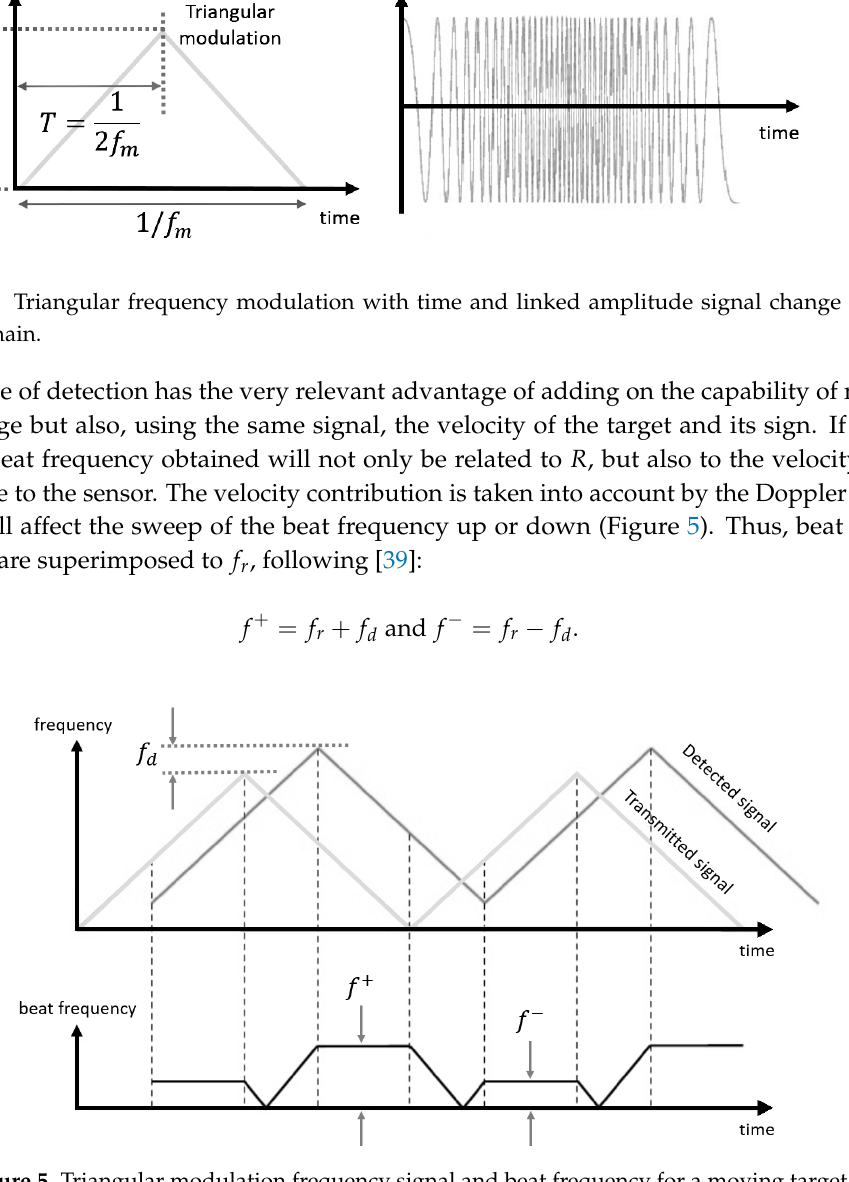
Figure 5. Triangular modulation frequency signal and beat frequency for a moving